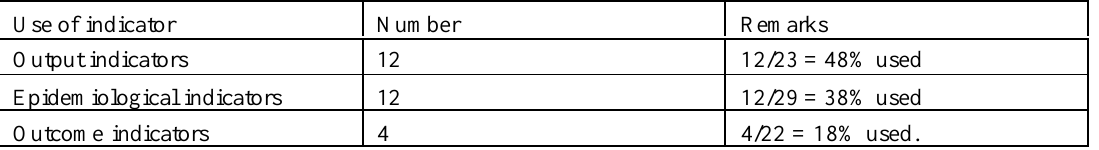
Table 5: Use of the indicators in the report Use of